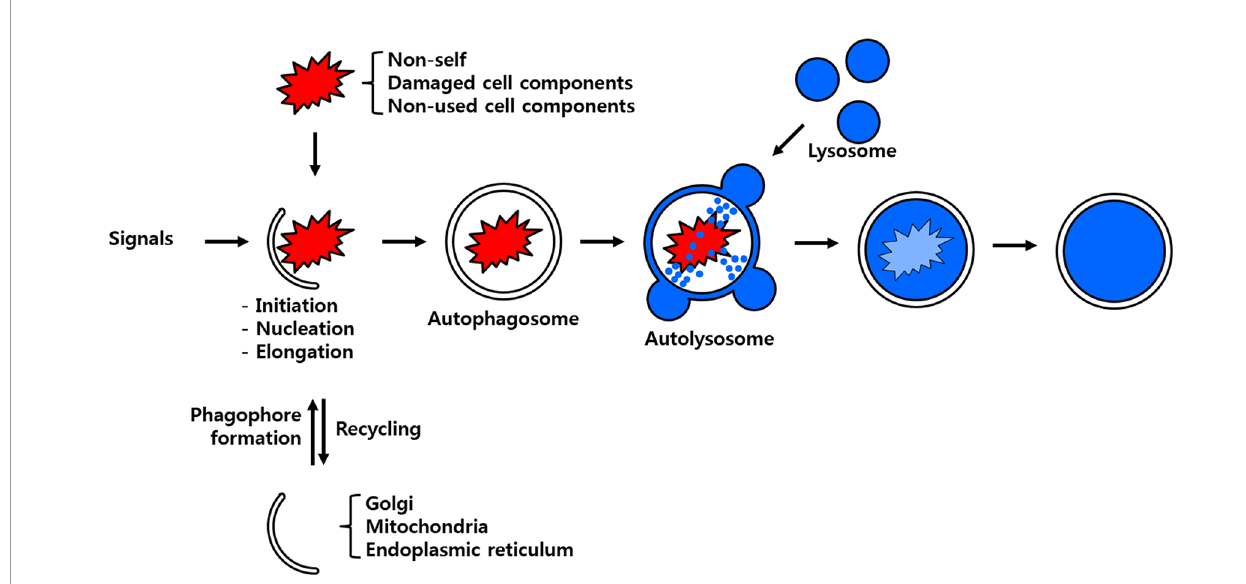
FIGURE 1 | Scheme of the process of autophagy. Non-self-entities such as pathogenic bacteria and unused or damaged cell components are enclosed by membrane particles believed to stem from the Golgi apparatus, mitochondria and/or endoplasmic reticulum. The developing autophagosome fuses with the lysosome to deliver its cargo to hydrolytic enzymes for eventual degradation and/or